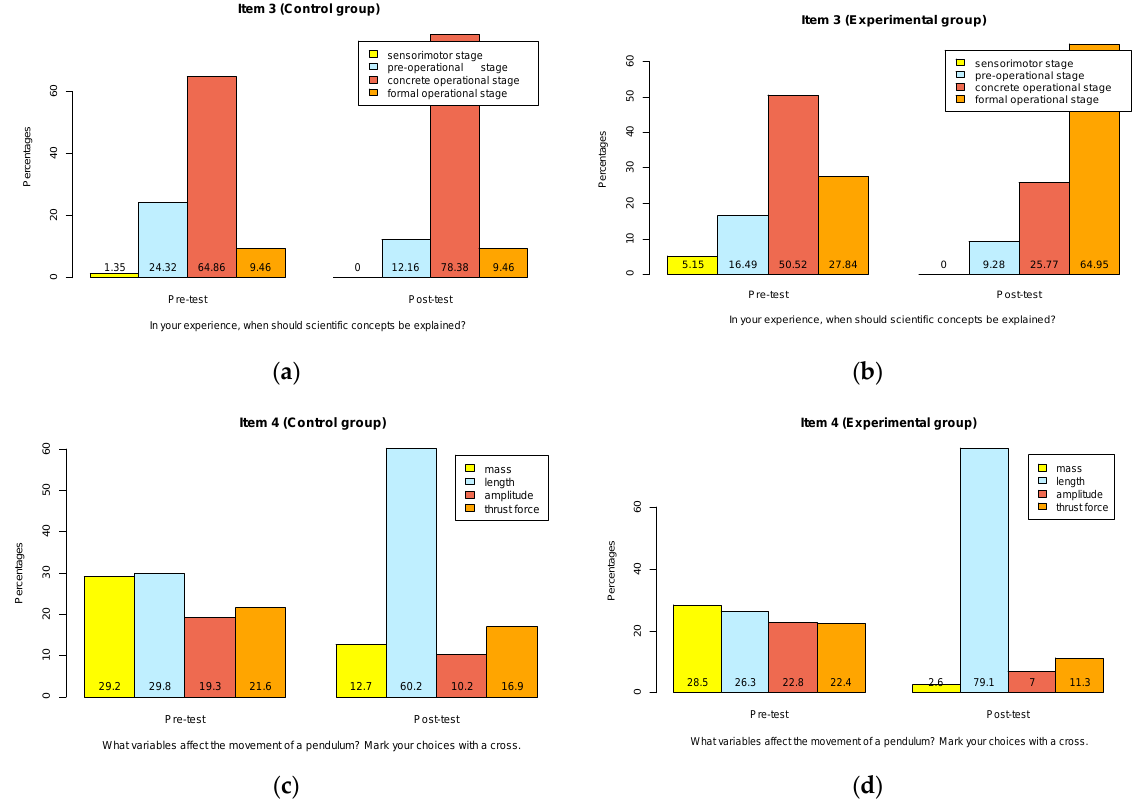
Figure 2. Item 3 is based on cognitive-algebraic thinking: ( a ) in the control group, it is not observed a relevant change; ( b ) in the experimental group, a significative change is observed, reinforcing the formal operations stage because of the need for abstract thought. In item 4, the length of pendulum choice was the main parameter selected in both groups, ( c ) and ( d ), thanks to an experimental interaction (inquiry method), being more efficient in experimental group ( d ).